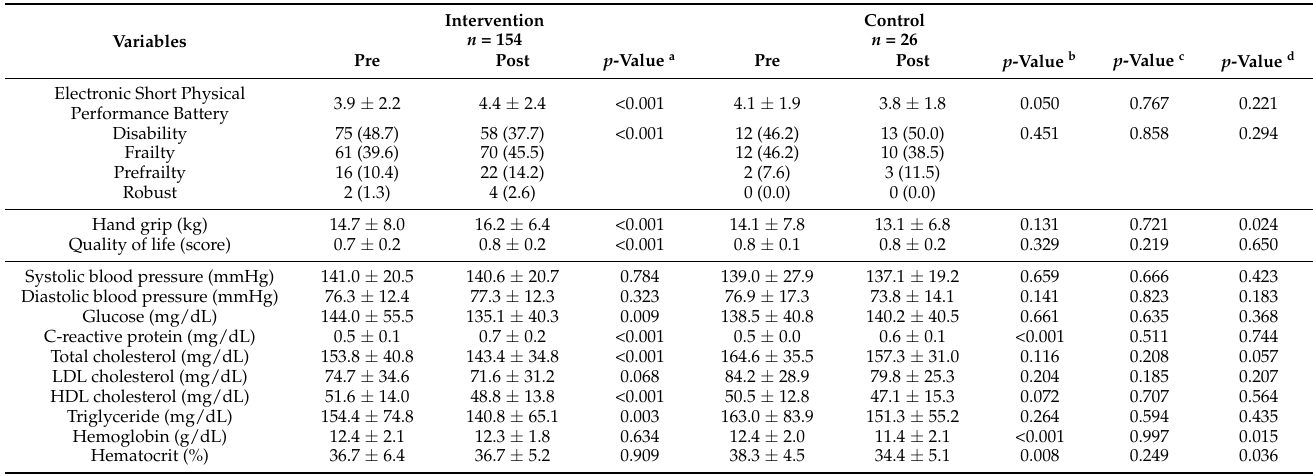
Table 3. Changes of functional capacity and clinical features for each group.